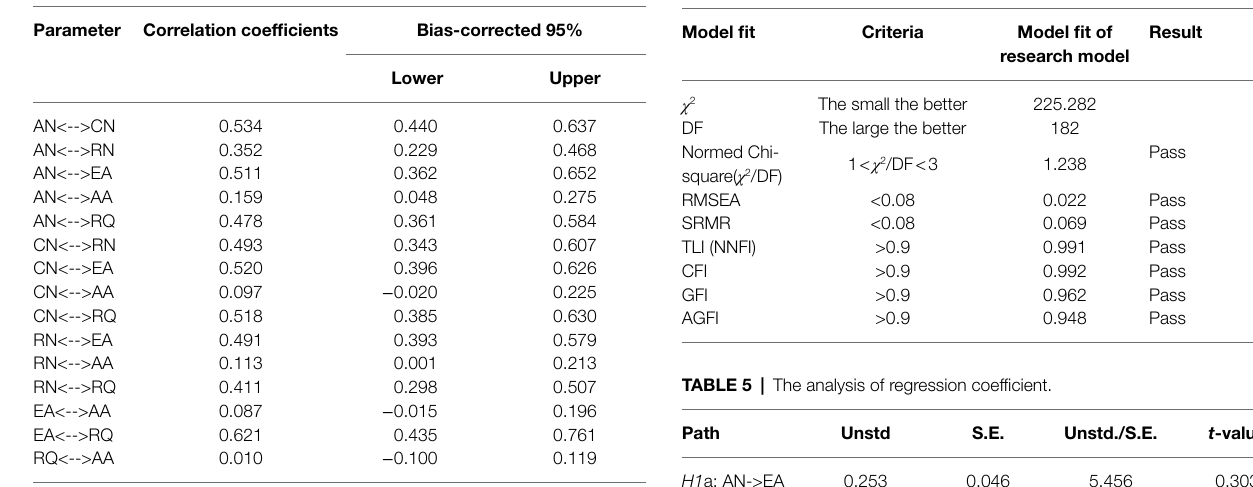
TABLE 4 | Model fit criteria and the test